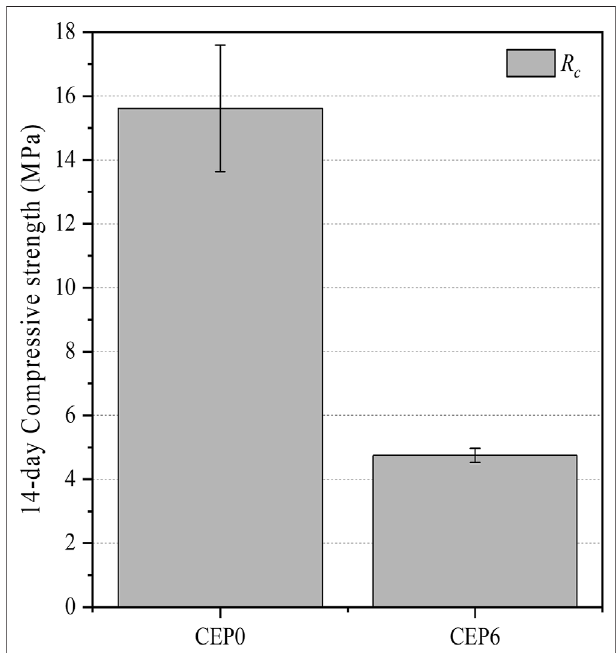
FIGURE 9 | The compressive strength of CEP6 and the reference